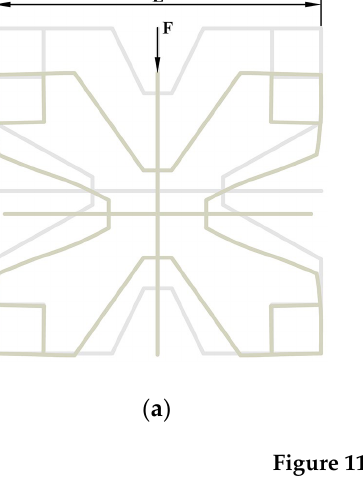
Figure 11. The deformation mechanism diagram and different geometric parameters of the auxetic unit cell: ( a ) Deformation mechanism of the auxetic cell under an external load; ( b ) Different concave depths of the auxetic cell (L = 70 mm); ( c ) Shematic diagram of the beam section size of the auxetic